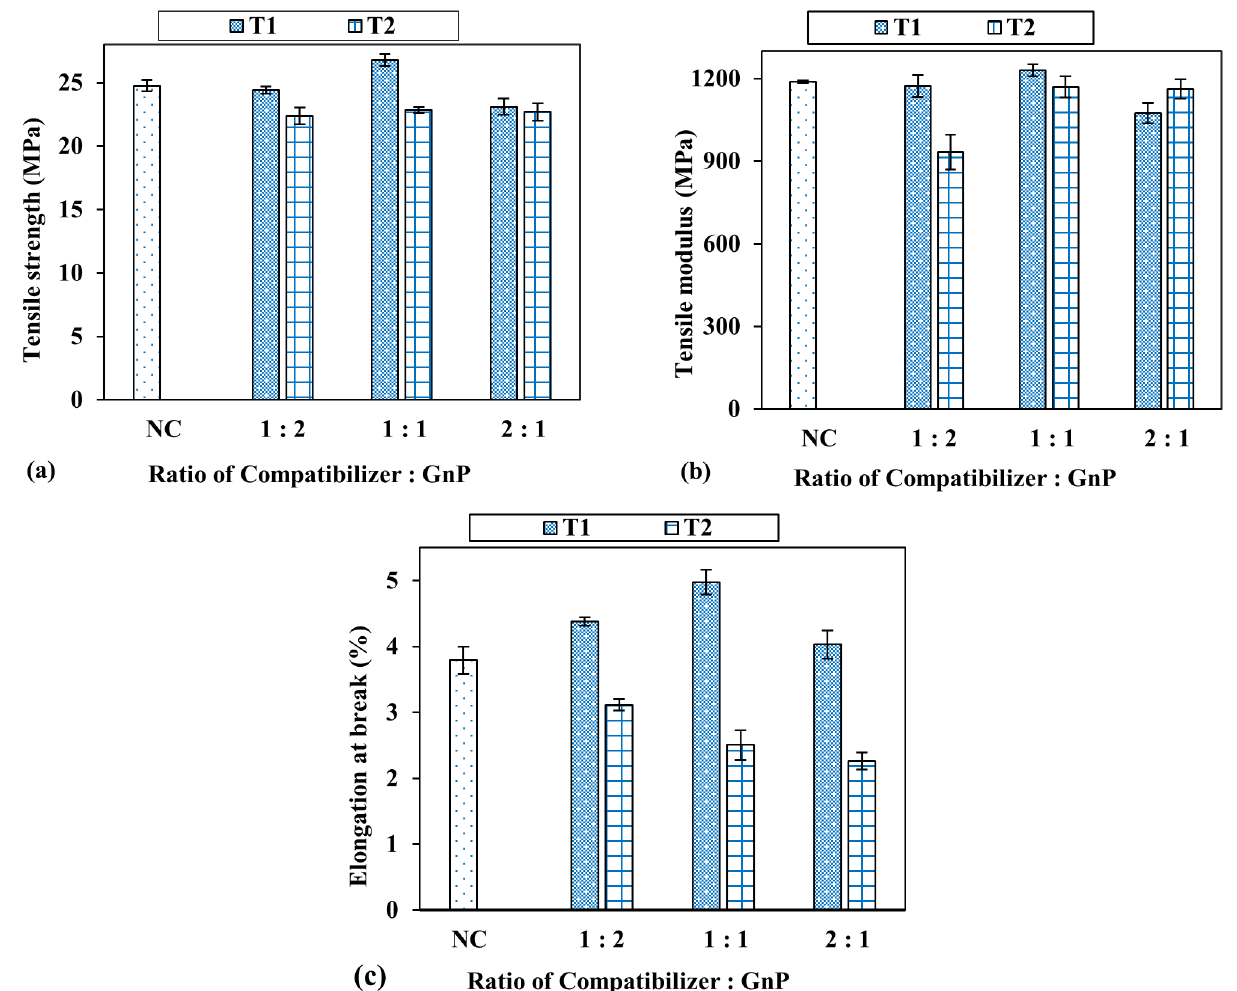
Figure 3. ( a ) Tensile strength, ( b ) tensile modulus and ( c ) elongation at break of